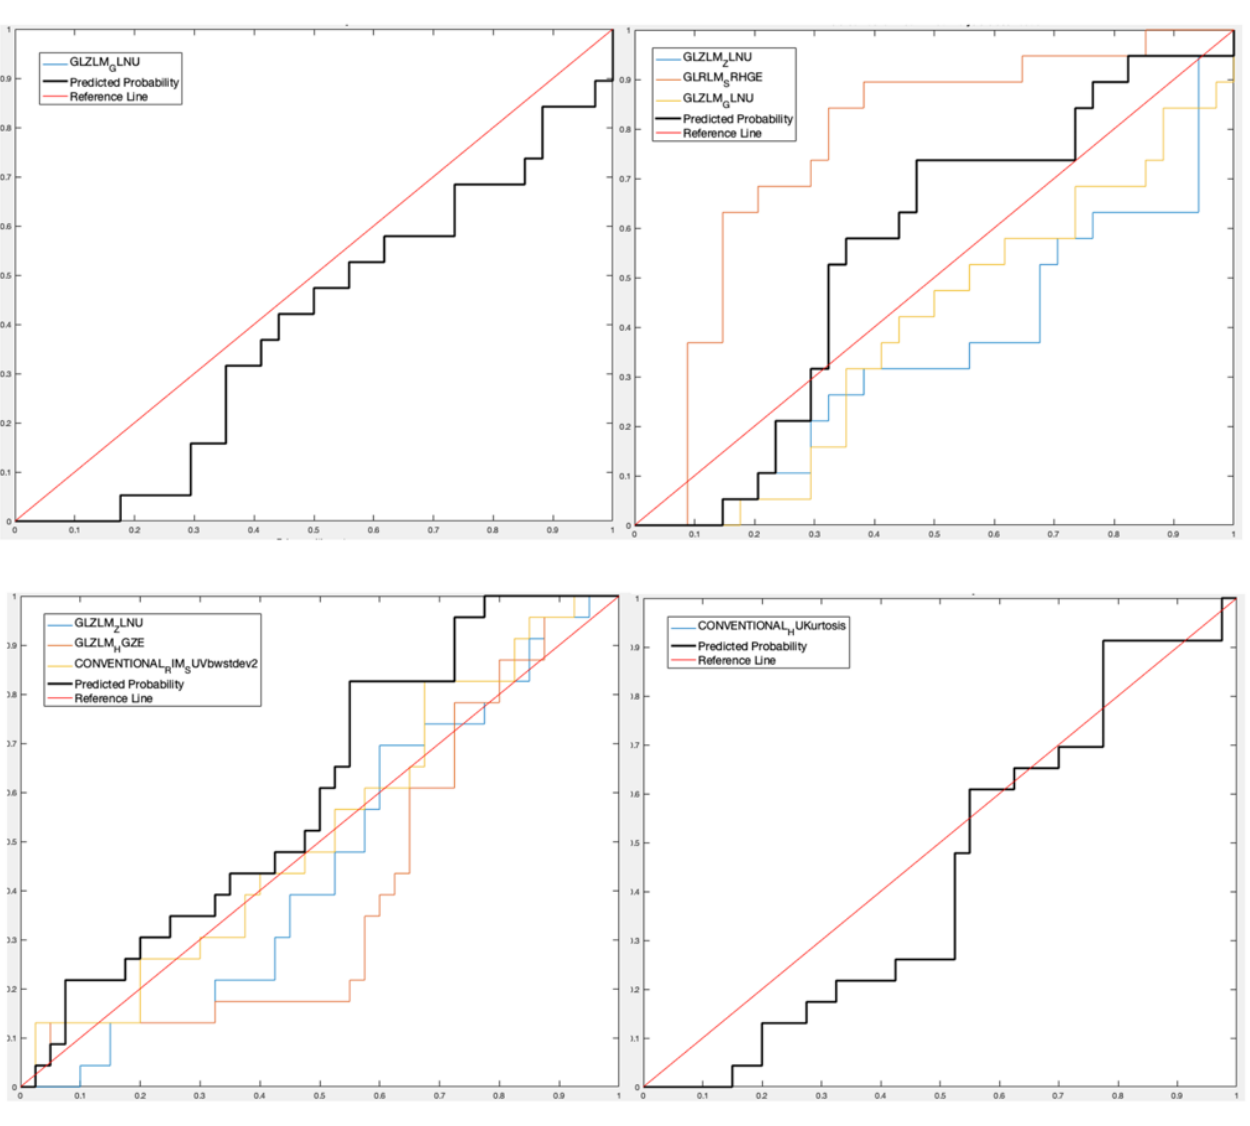
Figure 3. Liver subset: ROCs for the four radiomics models obtained per lesion (first row) and per-patient analyses (second row) for PET (first column) and PET/CT images (second column), with an AUROC of 39.94%, 55.26%, 60.11%, and 43.48%, respectively. Table 3. Radiomics features performance for liver lesions in prediction of disease progression per-patient and per-lesion analysis.